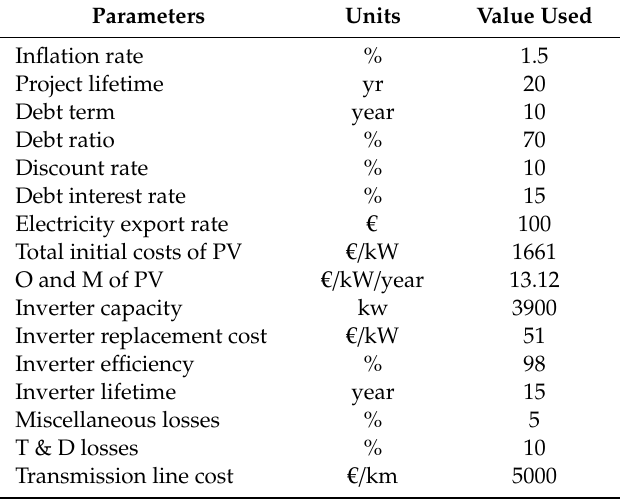
Table 4. Techno-economic input data for the analyses with RETScreen